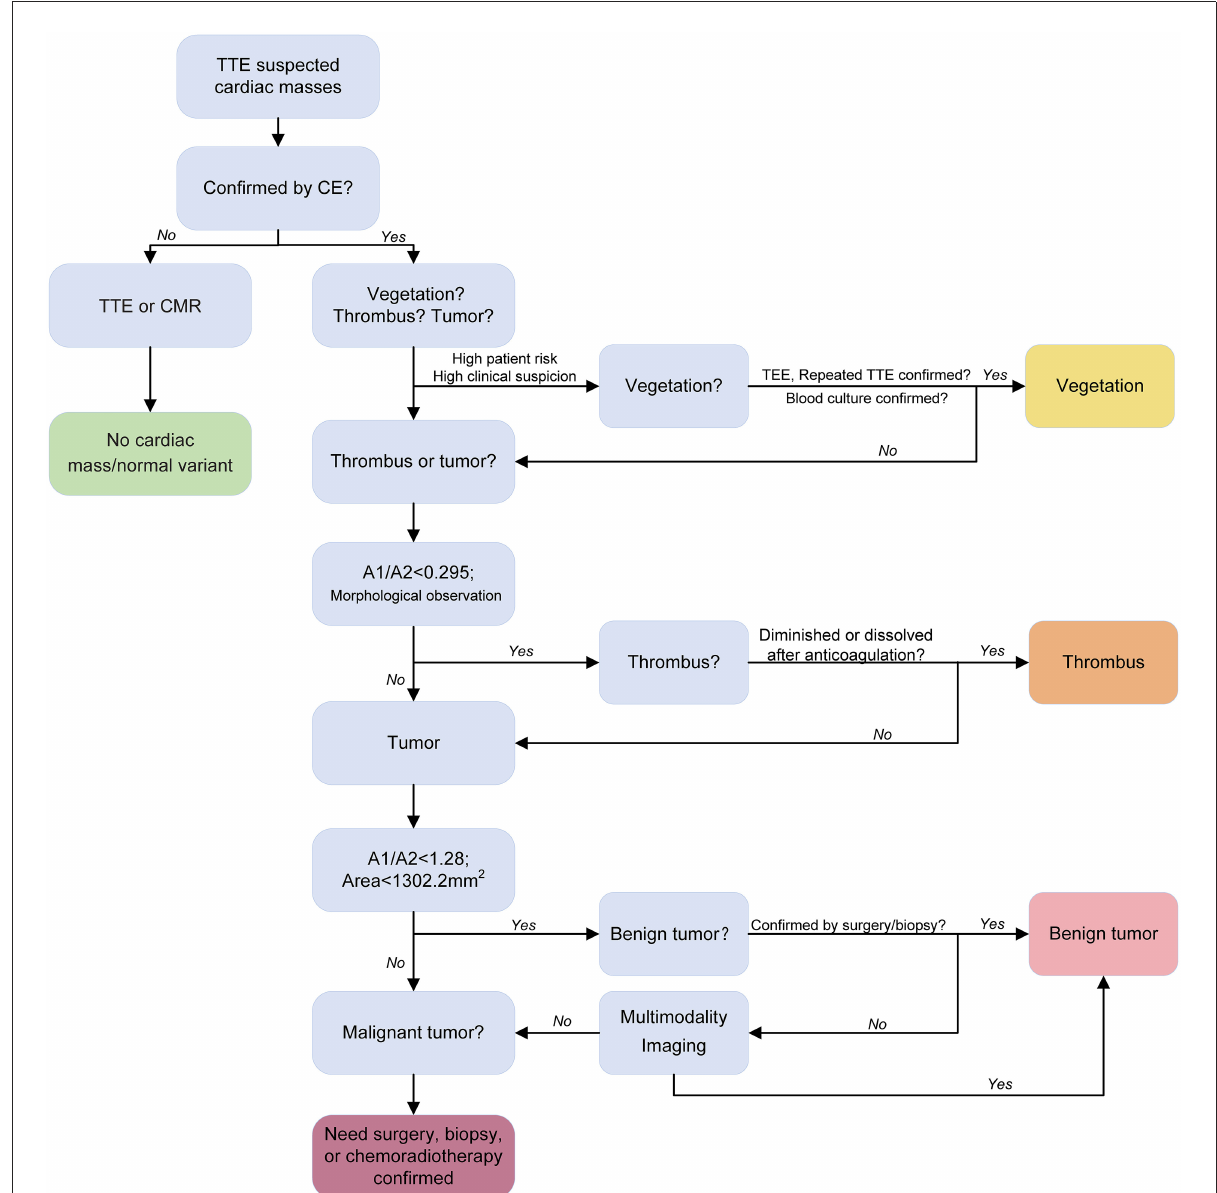
FIGURE4 Proposed diagnostic flow of cardiac tumors using contrast echocardiography. Transthoracic echocardiography and contrast echocardiography identified the cardiac mass (red